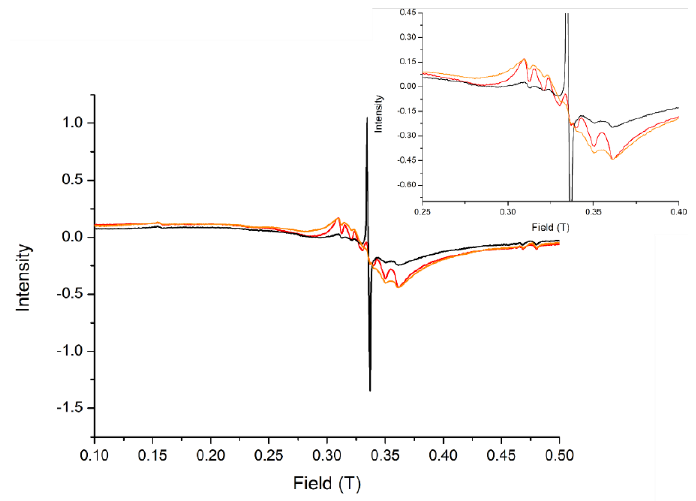
Figure 4. X-band EPR spectrum of [Mn II ]@RSNP (red line), [Mn II ]@SNP (orange line) and [Mn II ]@CSNP (black line) measured at 77 K. Inset: zoom of the main signal.